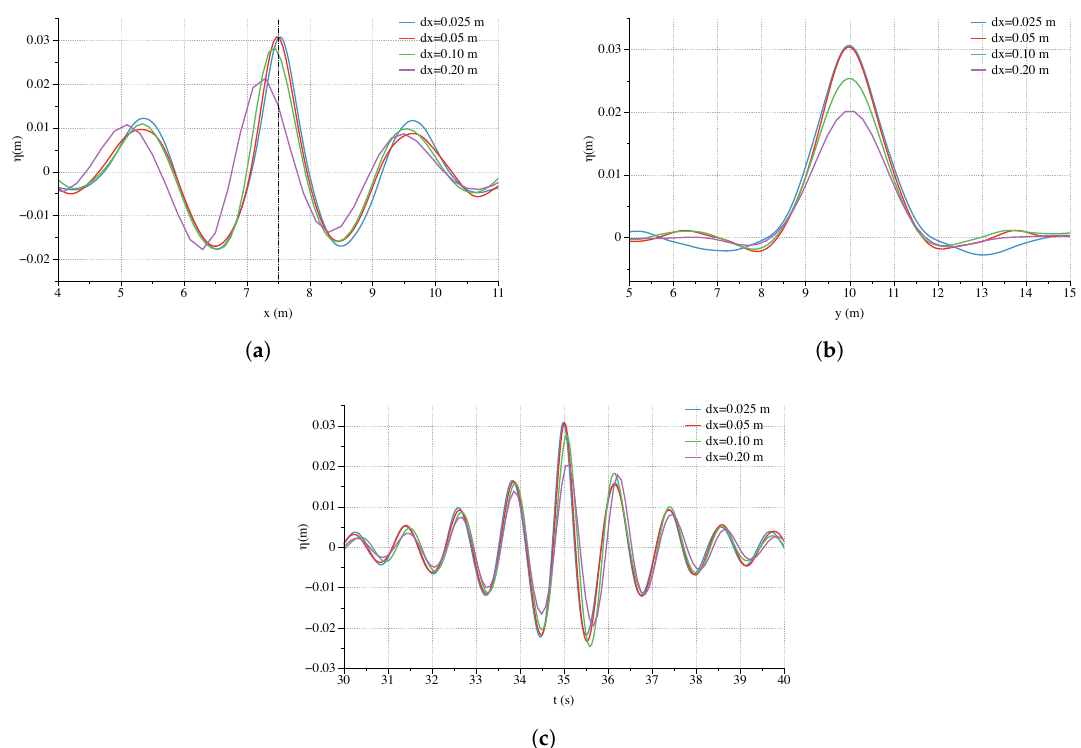
Figure 24. Grid convergence study for the 3D wave focusing simulation with four grid sizes dx = 0.025, 0.05, 0.1 and 0.2 m, 10 vertical cells are used in the study. ( a ) Wave profile along the x-axis at y = 10 m and t F = 35 s , ( b ) wave profile along the y-axis at x = 7.5 m and t F = 35 s, ( c ) free surface elevation time series at ( x , y ) = ( 7.5,10 ) m.